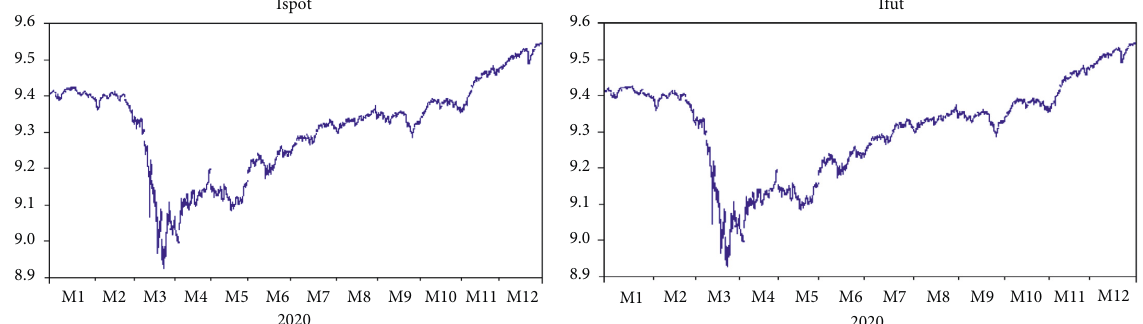
Figure 1: 1min time plot of spot and futures log prices. Source: authors’